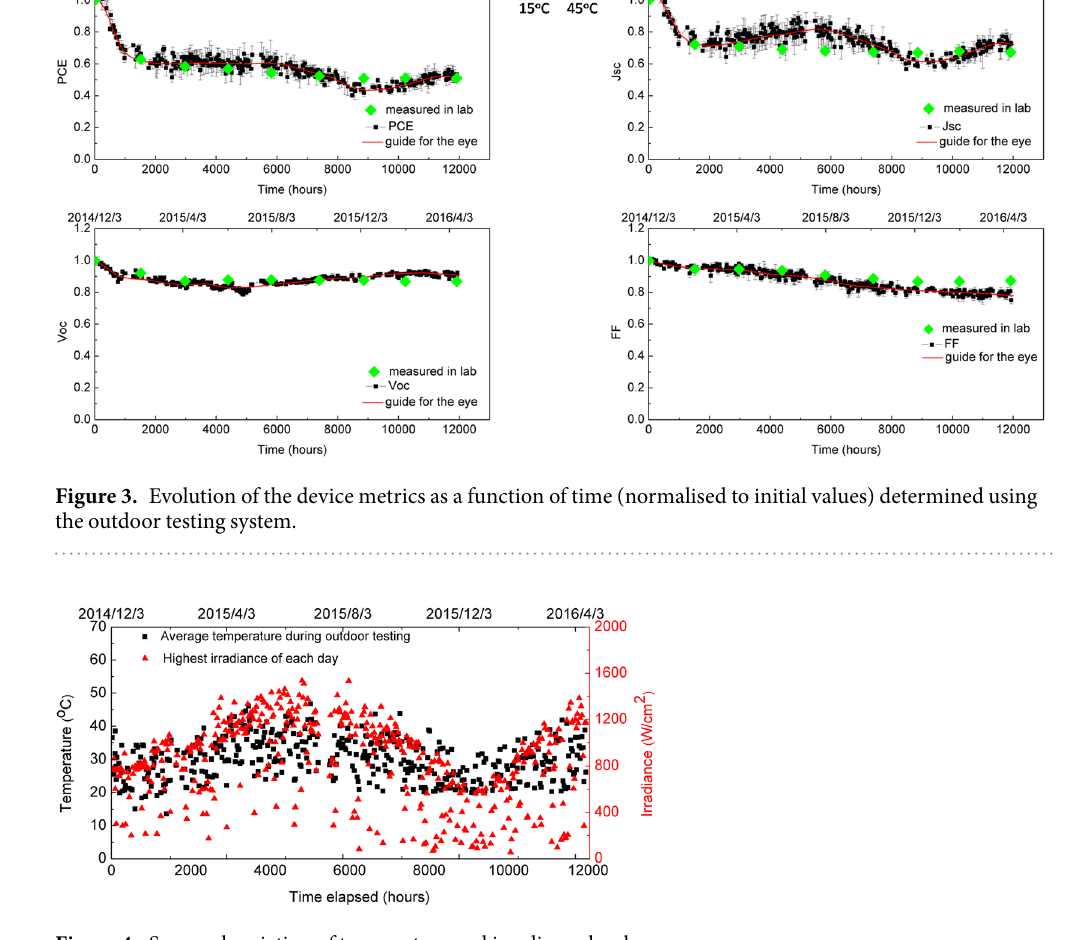
Figure 4. Seasonal variation of temperature and irradiance